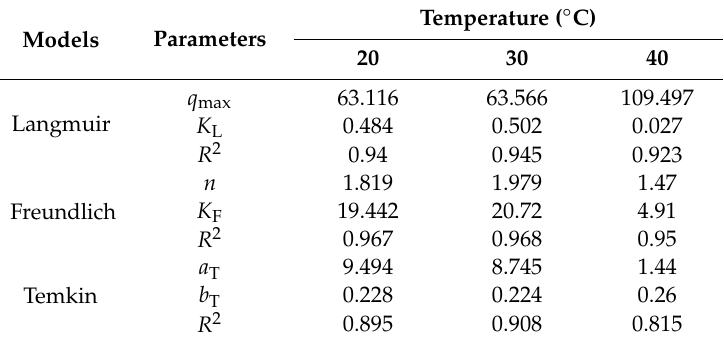
Table 2. Adsorption isotherm parameters for Cr(VI) adsorption onto